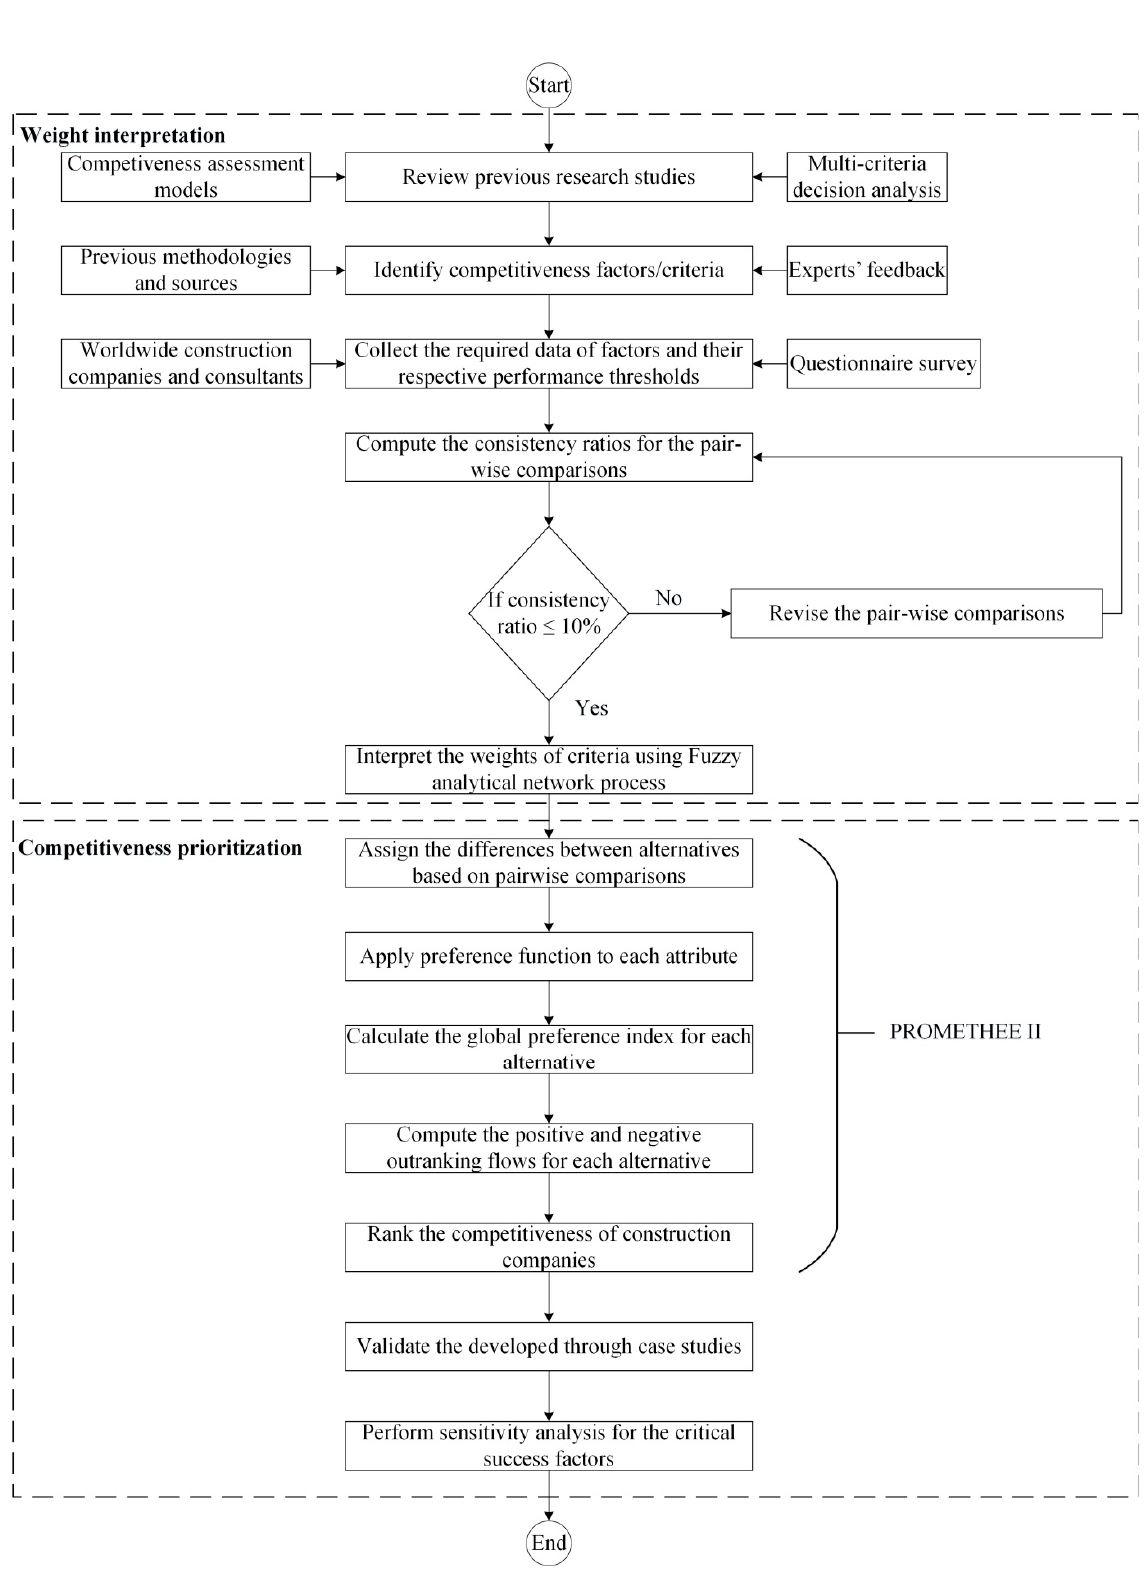
Figure 1. Framework of the developed competitiveness assessment model.